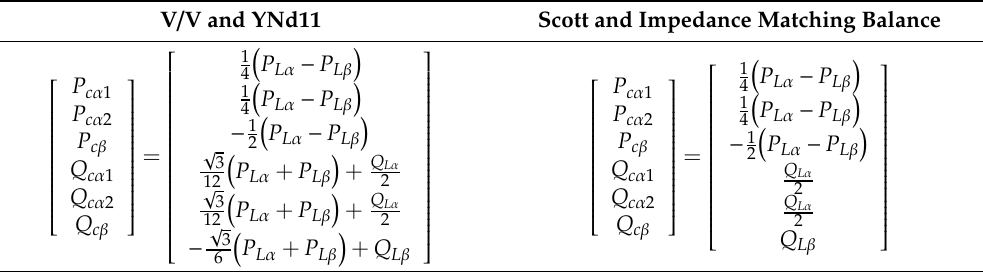
Table 1. Compensated power for di ff erent connections of traction transformer. V / V and YNd11 Scott and Impedance Matching